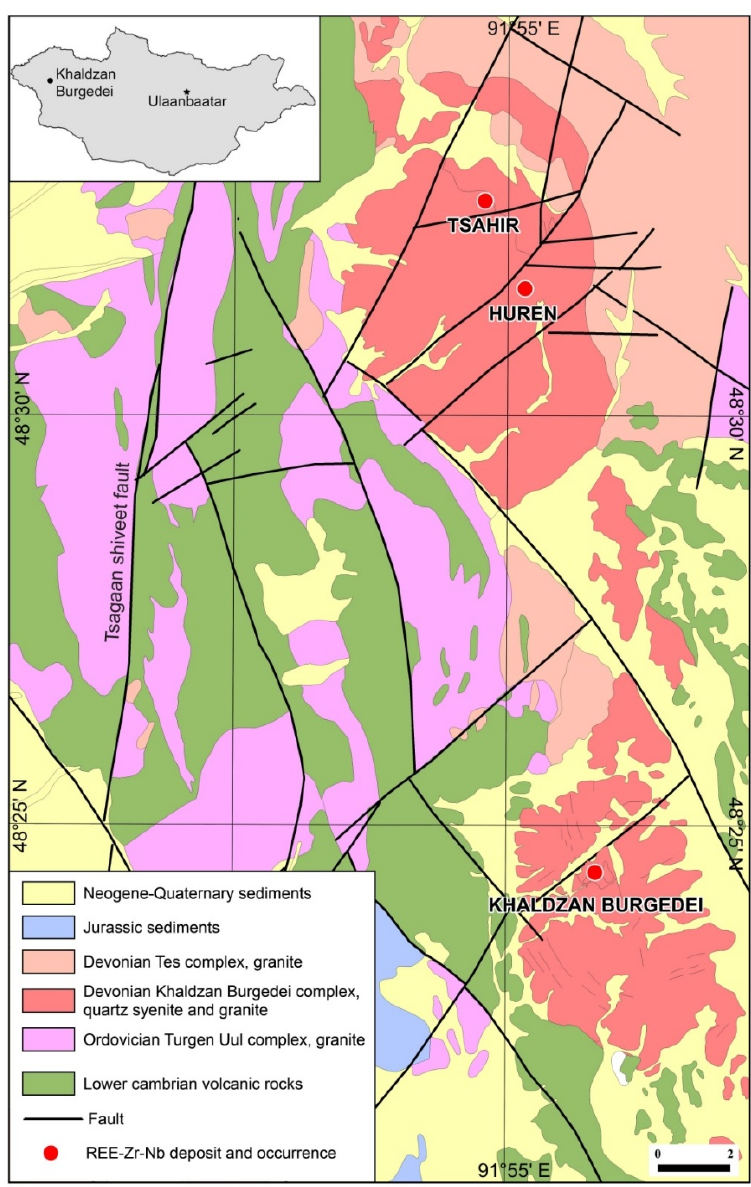
Figure 1. Regional geological map, modified from Miranov et al. [12].